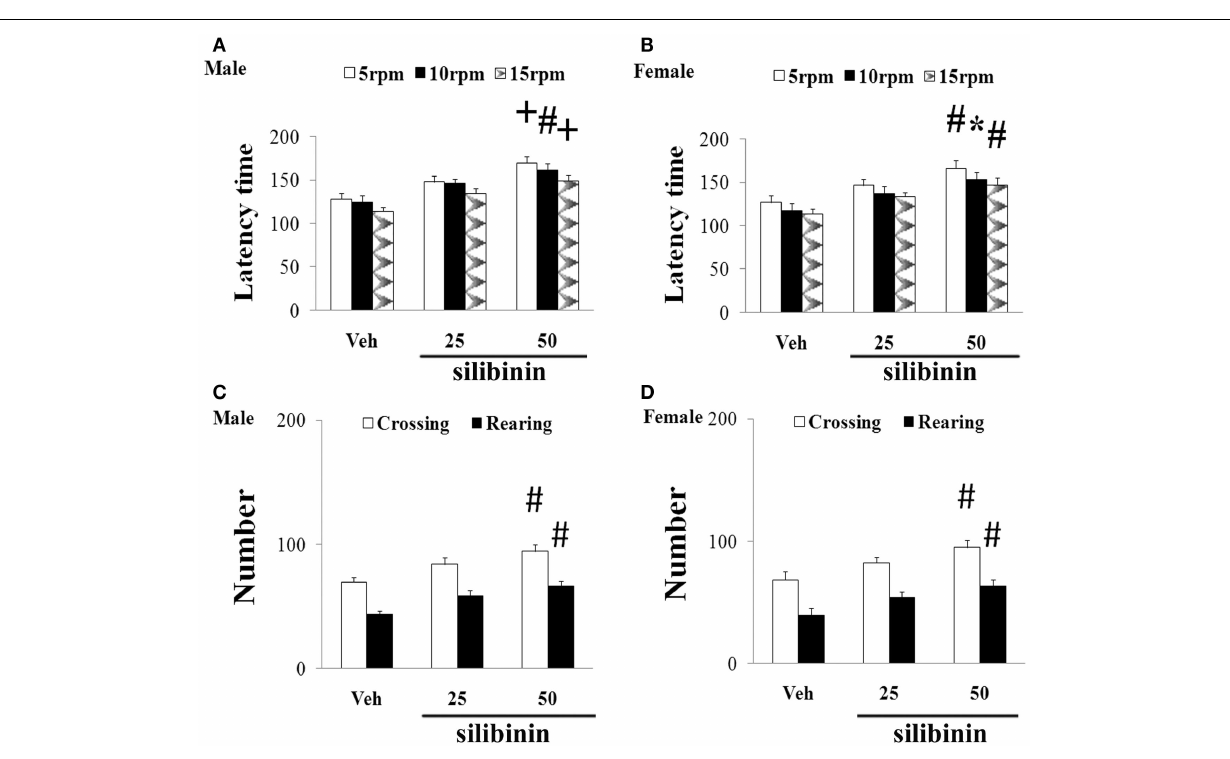
Frontiers in Aging Neuroscience |